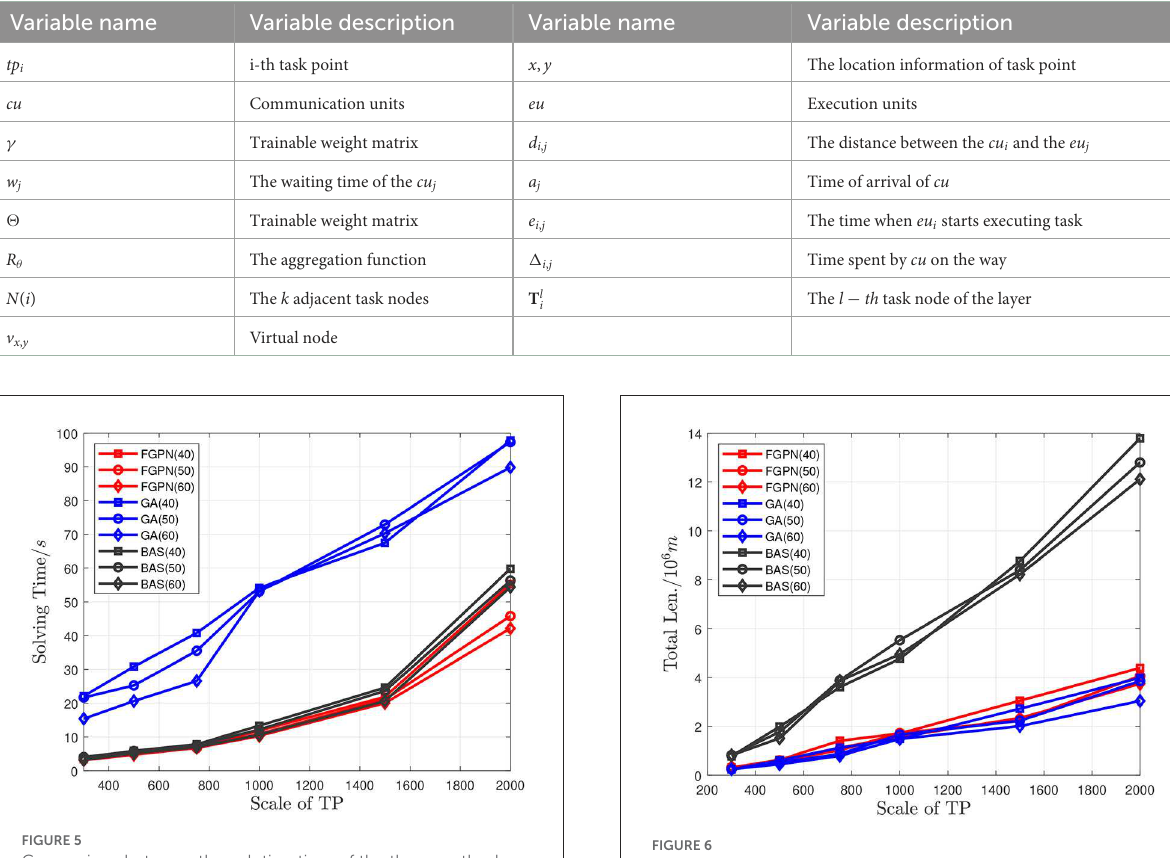
FIGURE5 Comparison between the solution time of the three methods and the scale of task nodes when the number of target task nodes in the task cluster is 40/50/60.